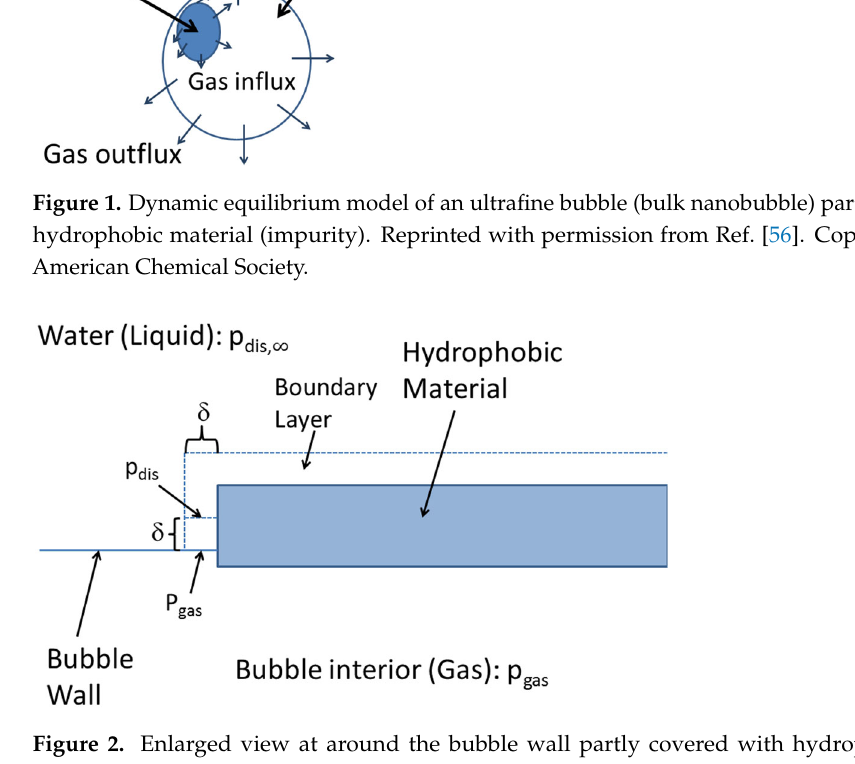
Figure 2. Enlarged view at around the bubble wall partly covered with hydrophobic material (im- purity). Reprinted with permission from Ref. [56]. Copyright 2016, the American Chemical Society.